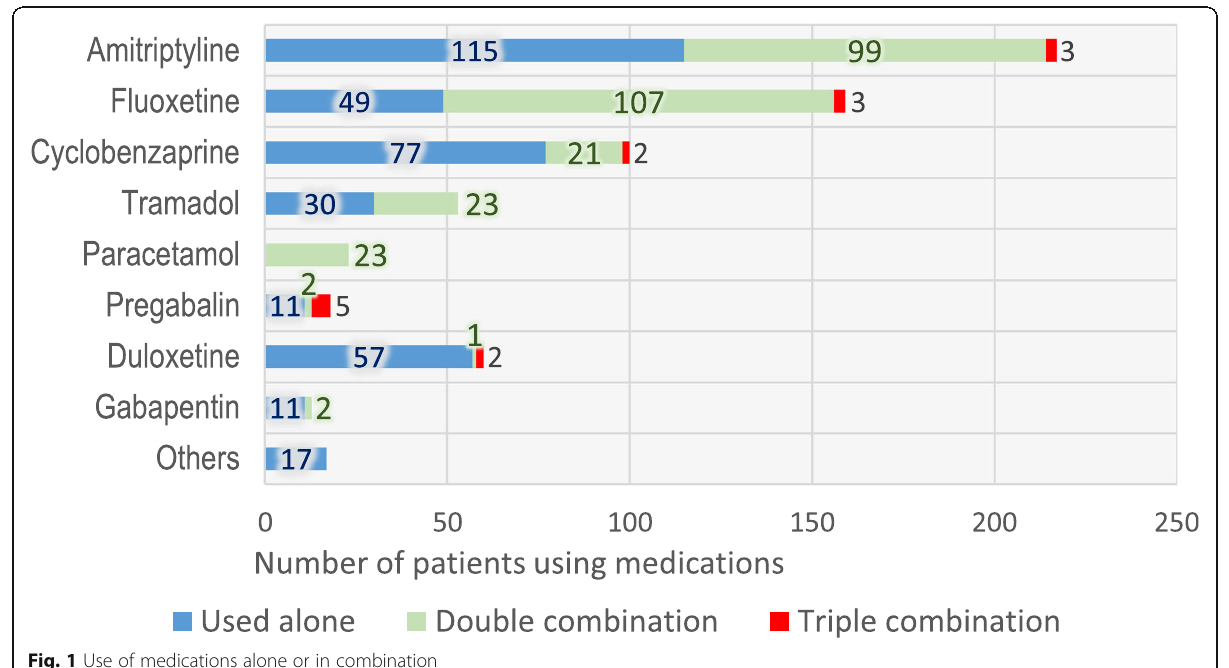
Fig. 1 Use of medications alone or in